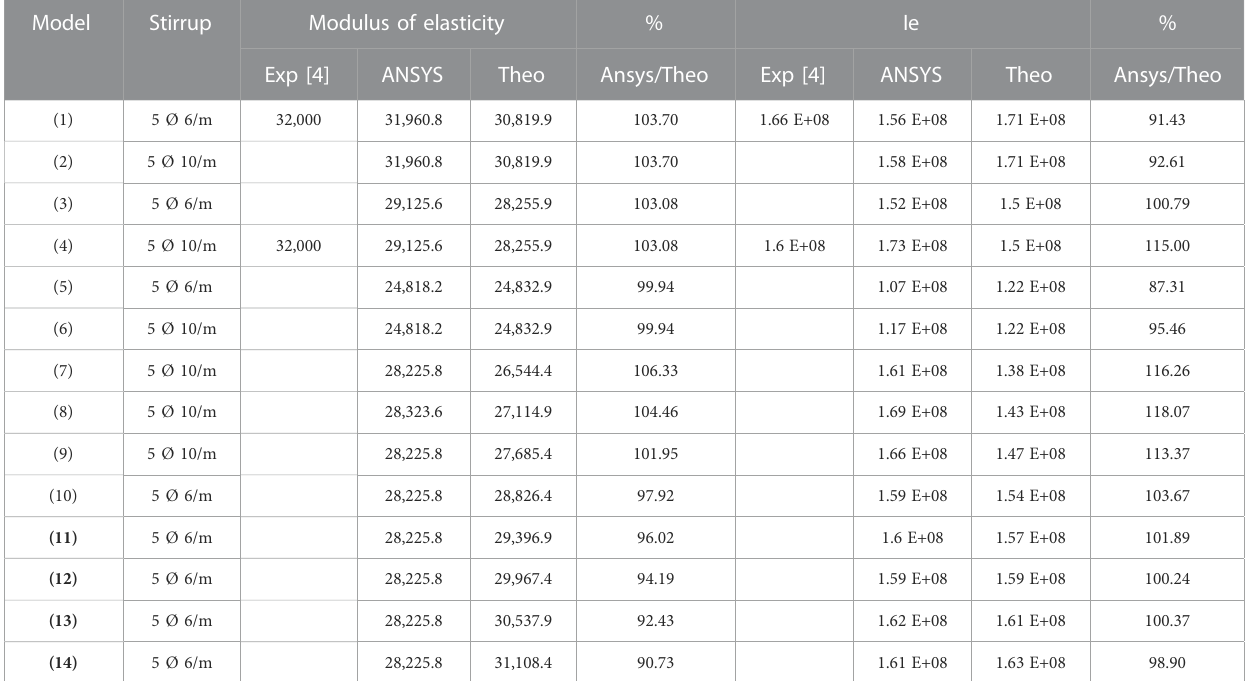
TABLE 4 Comparison results between the experimental, fi nite elements, and computational analysis at the modulus of elasticity and effective moment of inertia for all models. Model Stirrup